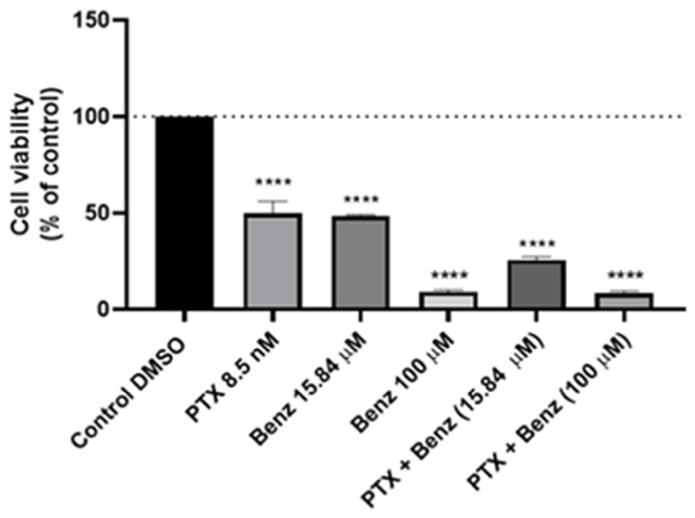
Figure 17. The effects of paclitaxel and benztropine (alone and in combination) on the cell viability (% of control) of MCF-7 cells at 48 h. Results are expressed as mean ± standard error of the mean (SEM) and represent four independent experiments (n = 4). **** p < 0.0001.